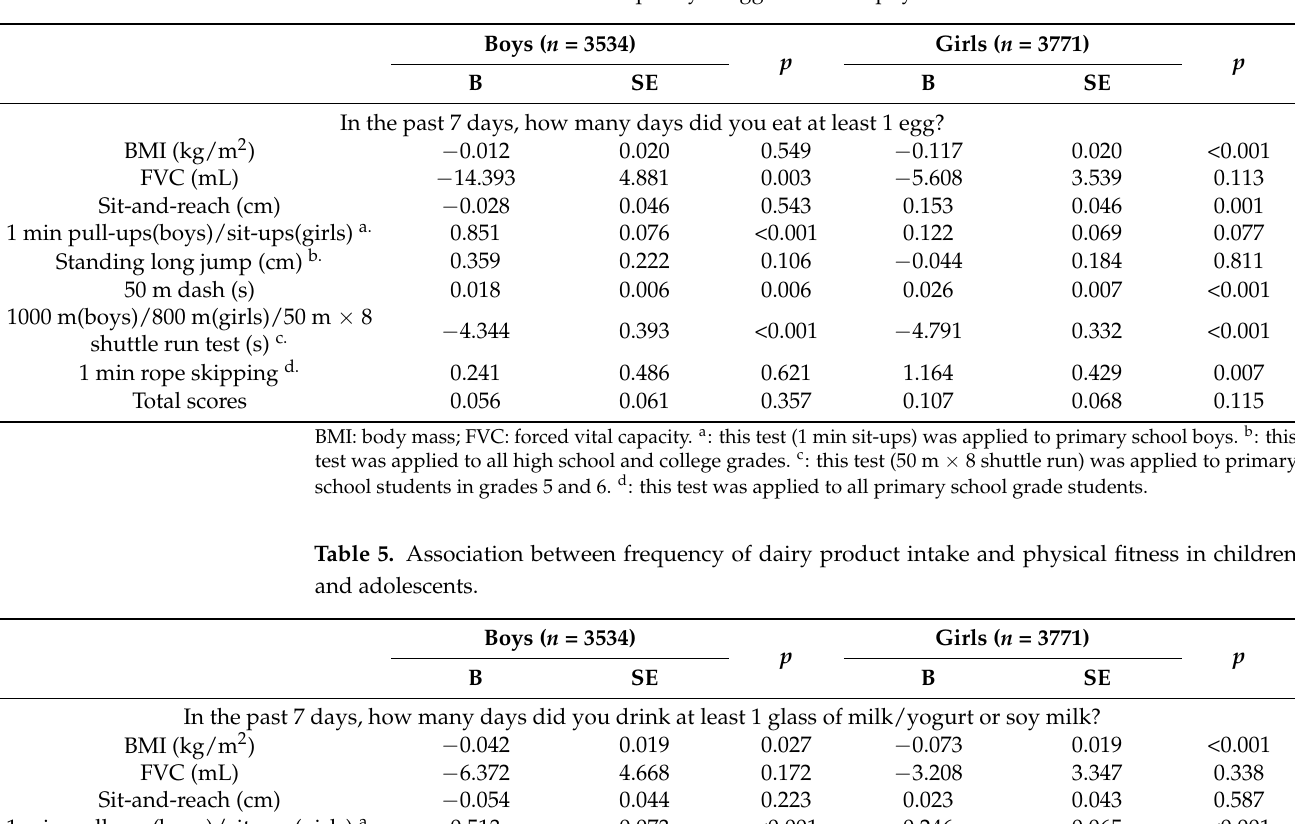
Table 4. Association between frequency of egg intake and physical fitness in children and adolescents.